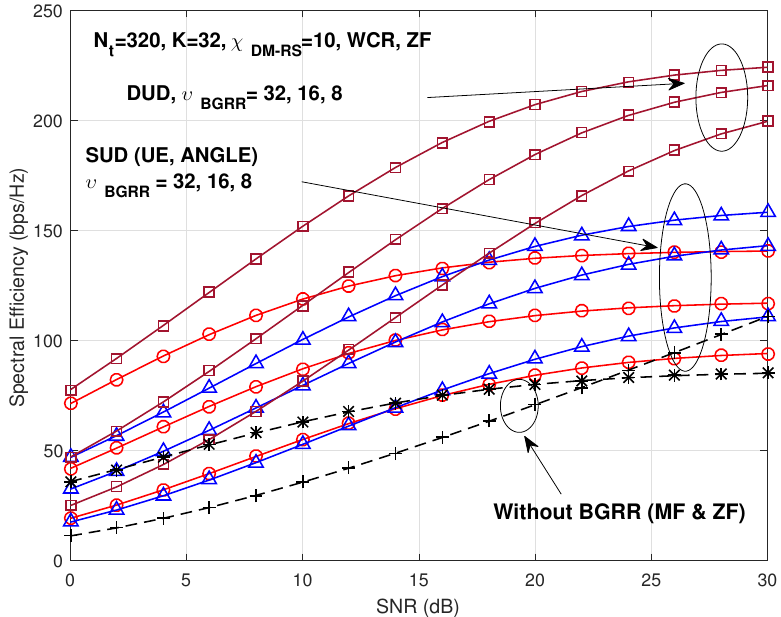
Figure 9. SE (bps/Hz) versus SNR (dB), when N t = 320, K = 32, χ DM − RS = 10, υ BGRR = 32,16,8, zero-forcing (ZF) group precoding. Red solid lines with ’ O ’ marks are the UE based grouping and blue solid ’ (cid:52) ’ marks are the angle based grouping.